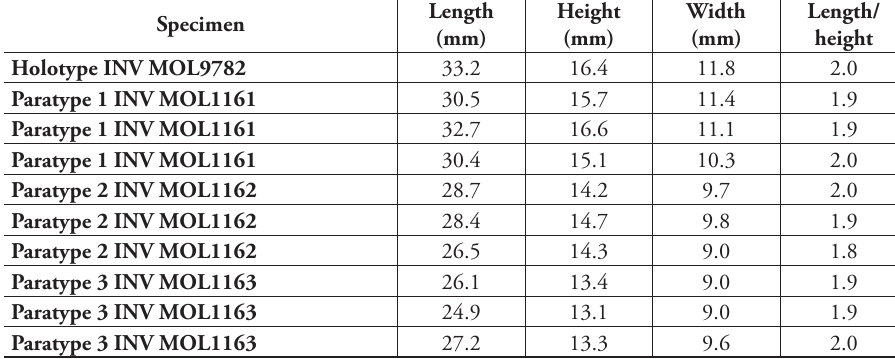
Table 2. Measurements of type specimens of Malletia tumaquensis sp. n.